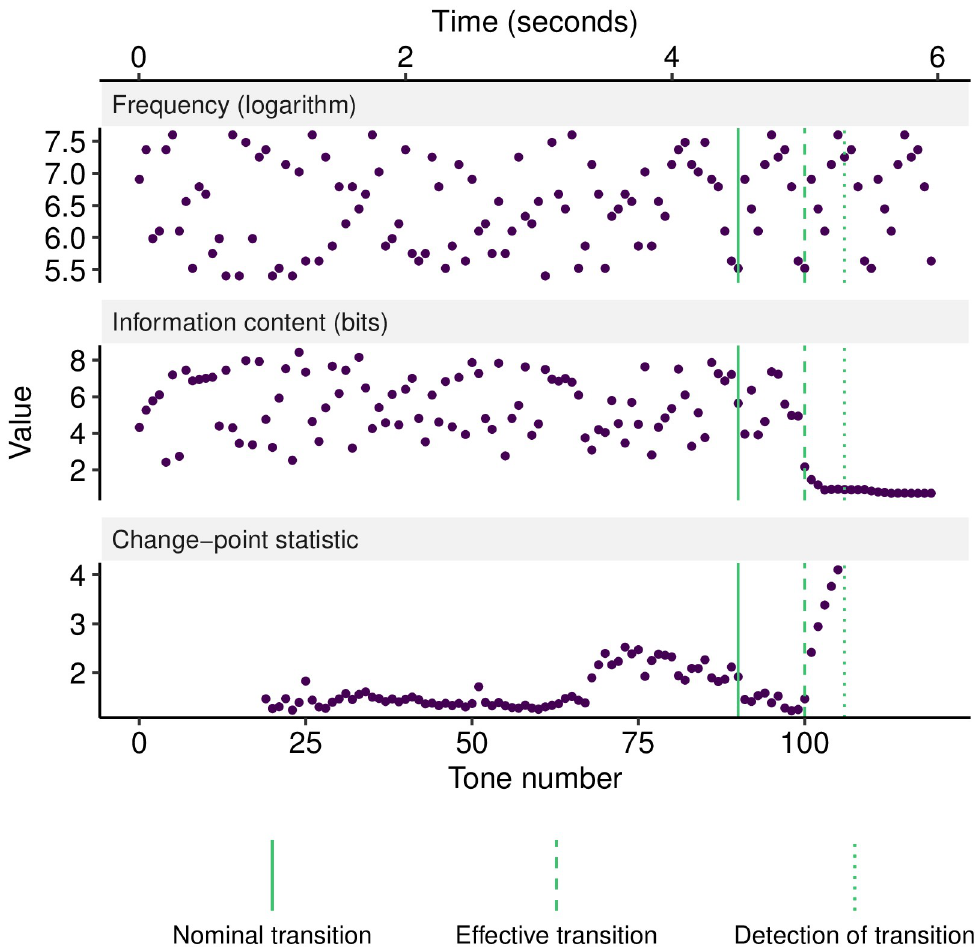
Fig 5. Example analysis of a single trial in Experiment 3. The three panels plot each tone’s frequency, change-point statistic, and information content respectively. ‘Nominal transition’ denotes the point at which the pattern changes from random tones to a repeating pattern of length 10. This repetition starts to become discernible after 10 tones (‘Effective transition’), at which point the sequence becomes fully deterministic. Correspondingly, information content (or ‘surprise’) drops, and triggers change-point detection at ‘Detection of